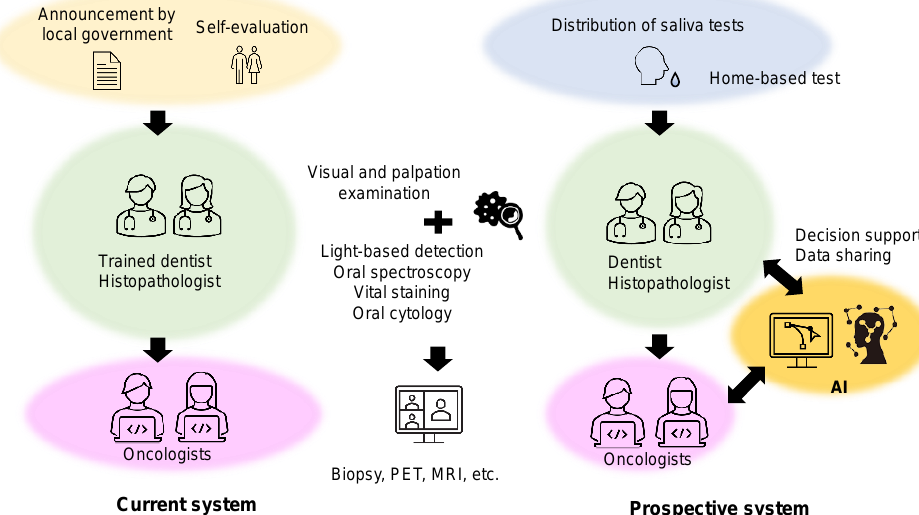
Figure 4. Current and prospective oral cancer screening systems.